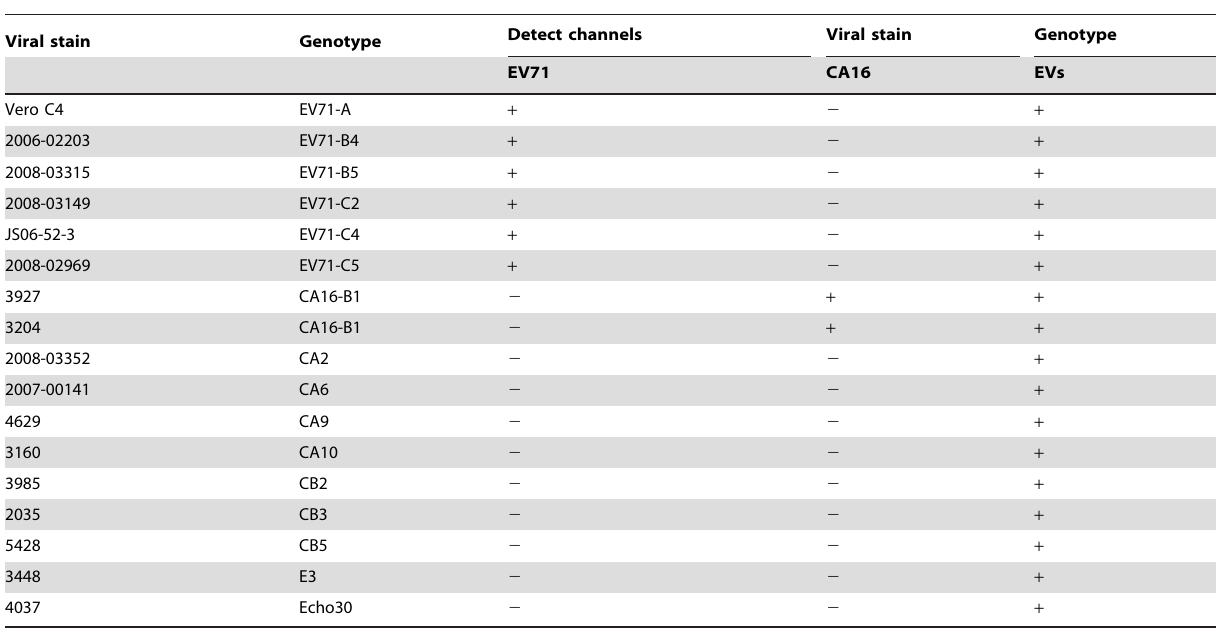
Table 2. Detection results for the HFMD viral stocks.